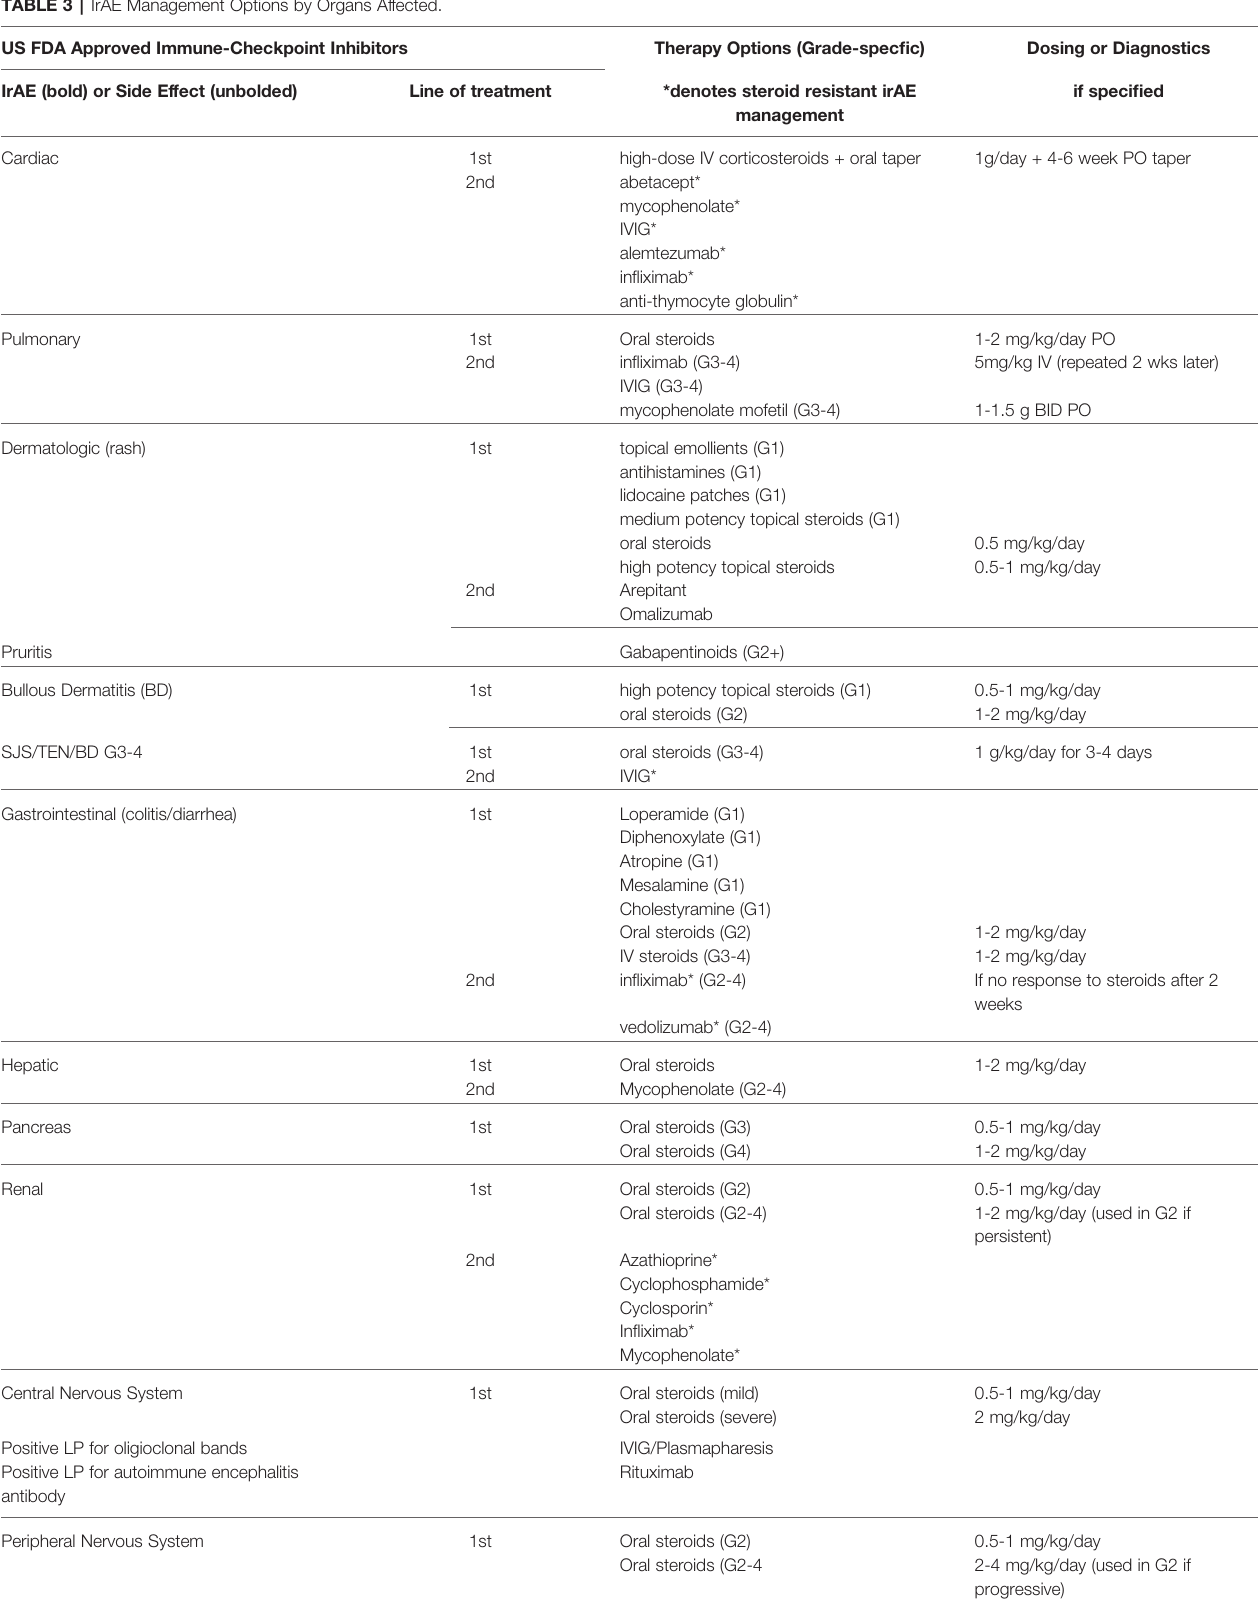
TABLE 3 | IrAE Management Options by Organs